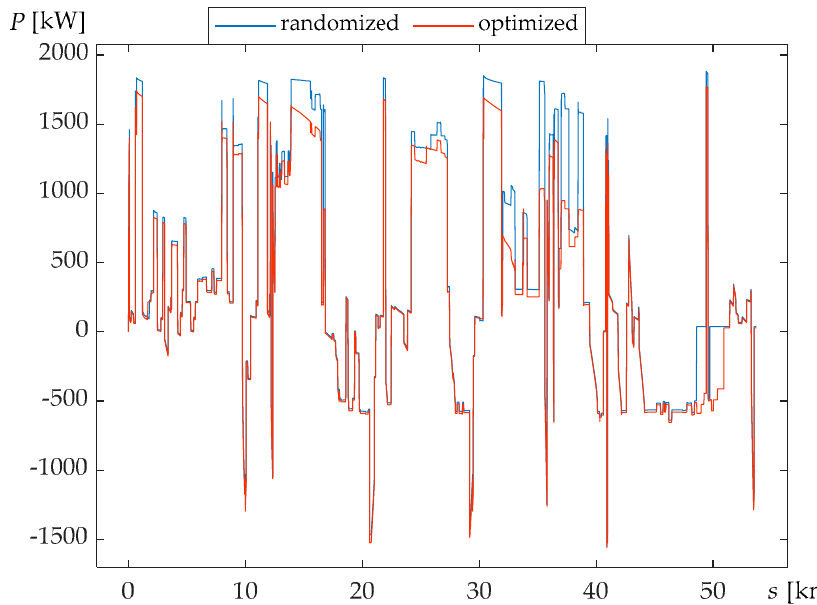
Figure 11. Demand for power (red is optimized, blue is randomized).